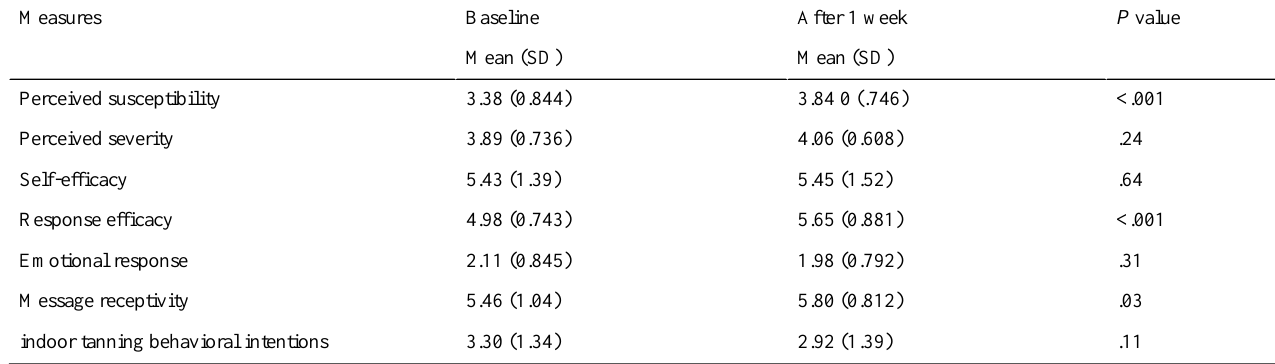
Table 2. Comparison of measures at baseline and 1 week (N=21).